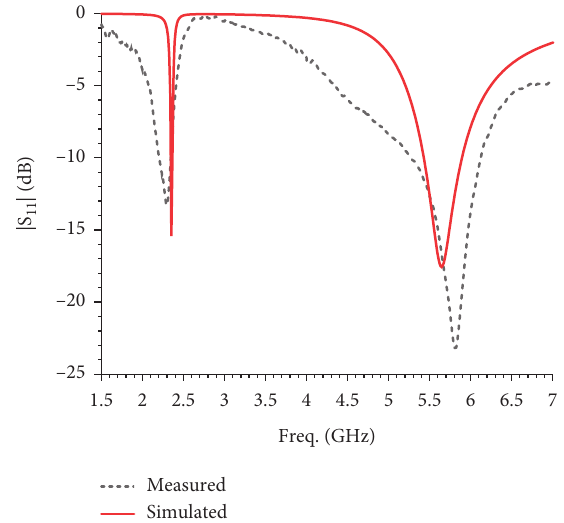
Figure 3: Simulated and measured S11 of the proposed ram horn-like folded antenna.